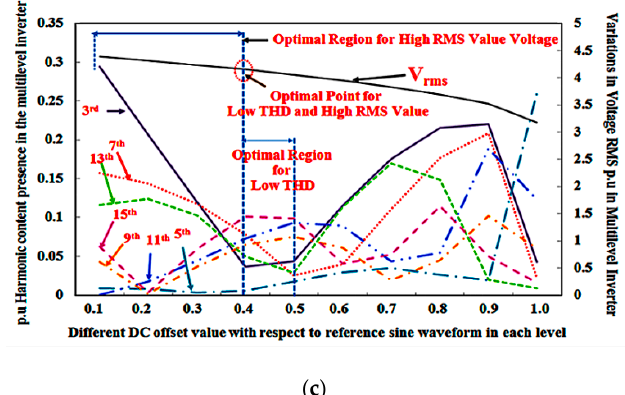
Figure 7. ( a ) A functional block diagram of the proposed system ( b ) DC offset 0.4 compared with reference waveform and pulse generation method; ( c ) the various DC offset values with corresponding THD.